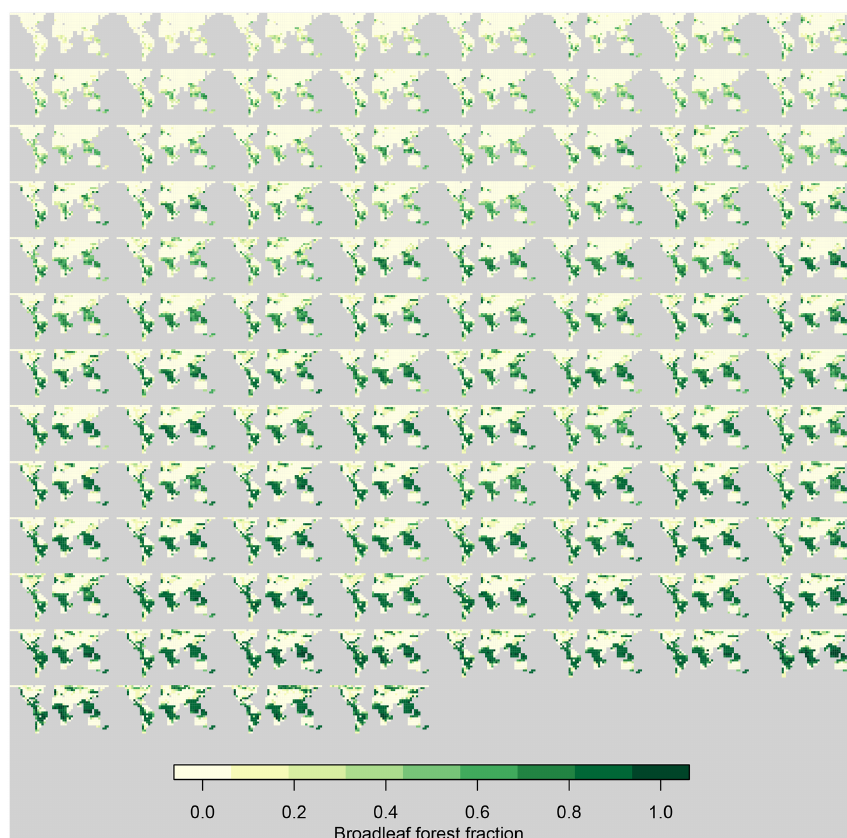
Figure 1. Broadleaf forest fraction in the FAMOUS ensemble, ranked from the smallest to largest global mean